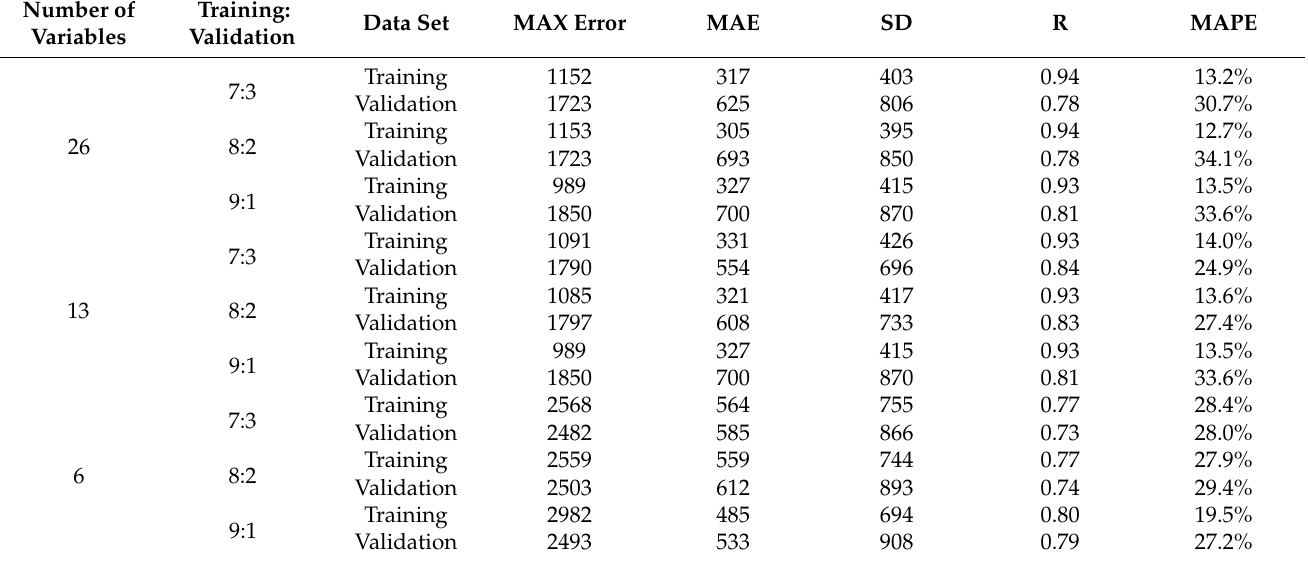
Table A10. Analysis of the results of the SR model for natural gas consumption.